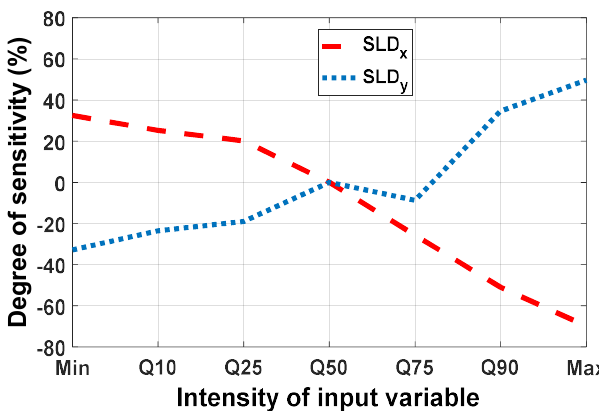
Figure 9. Degree of sensitivity (in %) of SLDx and SLDy on the prediction of critical buckling load through the ANFIS-BBO model. Table 6. Summary of the degree of sensitivity (in %) of input variables at different intensity values.